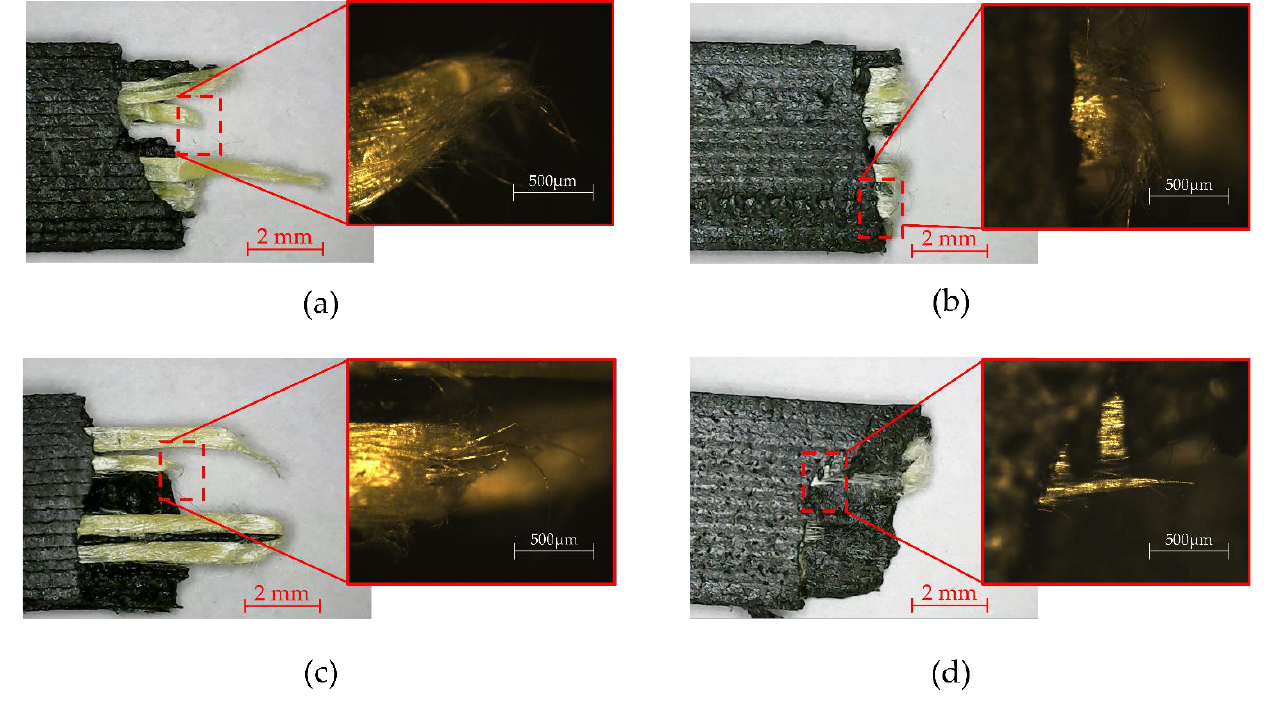
Figure 7. ASTM D3039 tensile failure mechanisms and composite behavior presented in Onyx™– Kevlar ® samples and microscopic view. ( a ) AGM with fiber debonding, ( b ) LGM with fiber-matrix breakage, ( c ) DGM with matrix breakage and ( d ) DGM with fiber pull-out.